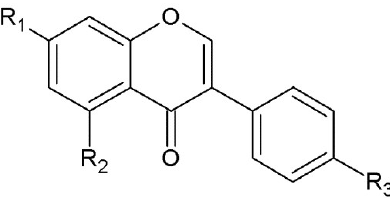
Figure 4. The structure of isoflavones (R 1 =R 3 =OH, R 2 =H—daidzein; R 1 =O-Glc, R 2 =H, R 3 =OH—daidzin; R 1 =R 2 =R 3 =OH—genistein; R 1 =O-Glc, R 2 =R 3 =OH—genistin).